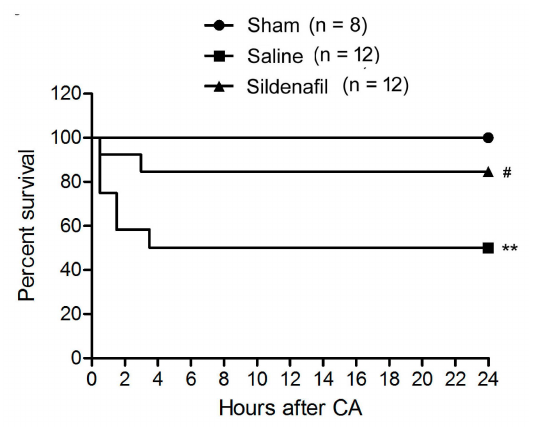
Figure 1. Survival curve of animals in the present study. ** p < 0.01 vs. Sham, # p < 0.05 vs. Saline.